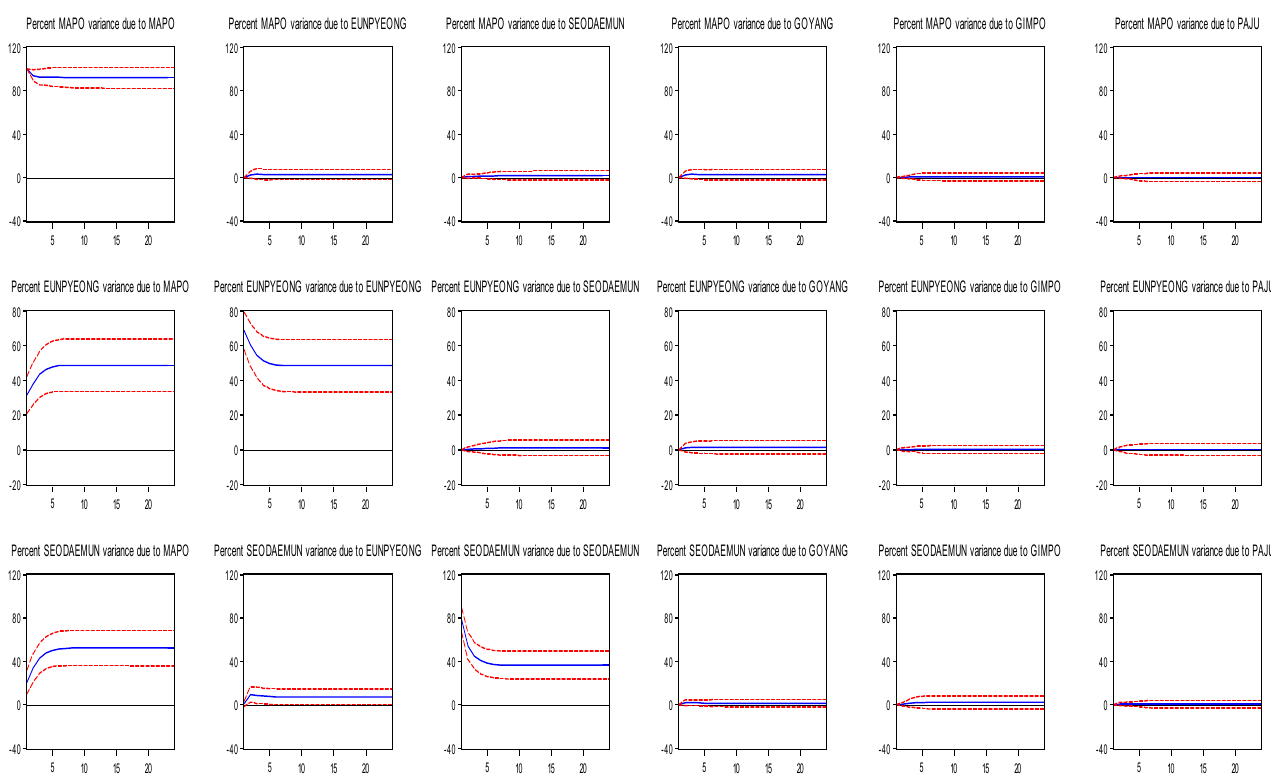
Figure 9. Variance decomposition analysis of the housing sales markets in the Northwest region.